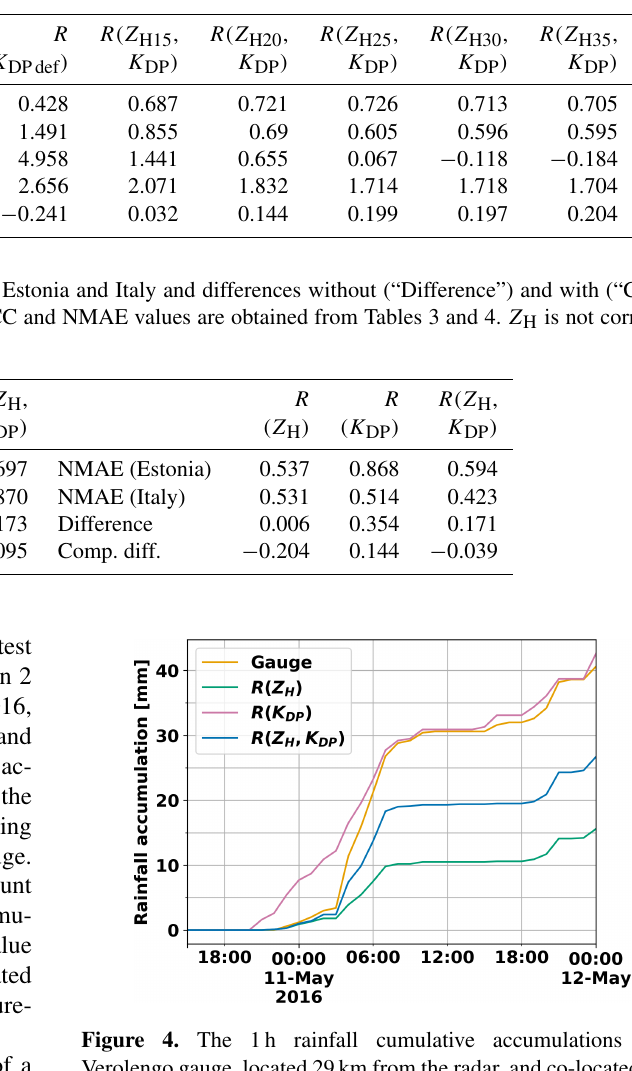
Table 1. Verification results of the test dataset of 1 month (August 2018) of the radar-based rainfall 1h accumulation products of Estonia. Z H is not corrected for attenuation.